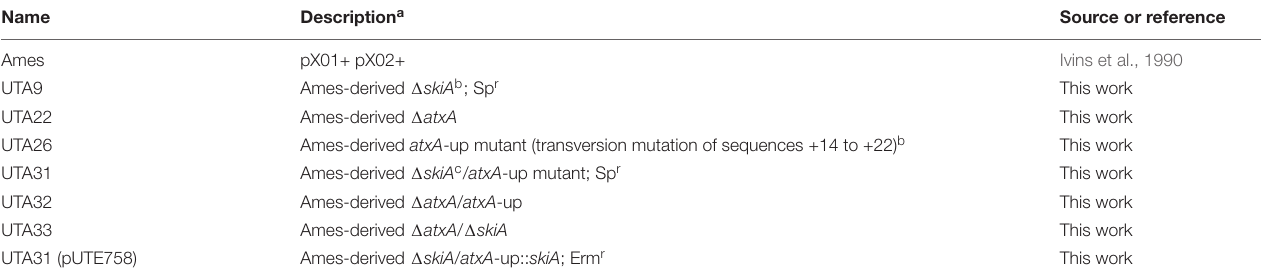
TABLE 1 | Strains used in this